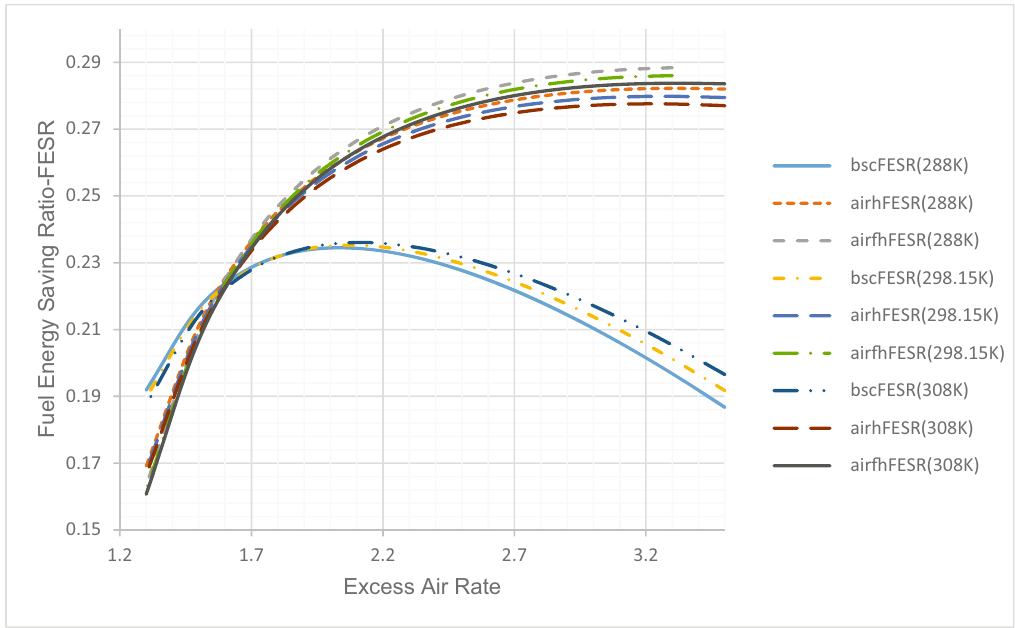
Figure 12: Variation of FESR with excess air coe ffi cient at di ff erent compressor inlet air temperatures for basic ( bsc ) , absorption cooling ( ab ) , air ( airh ) , and air fuel ( airfh ) heating cogeneration cycles ( m fuel = 1.64 kg/h, η isC = η isT = 0.86, r = 10, T recout = 850 K, T steam = 485.57 K, and T = 426 K ) . Exh